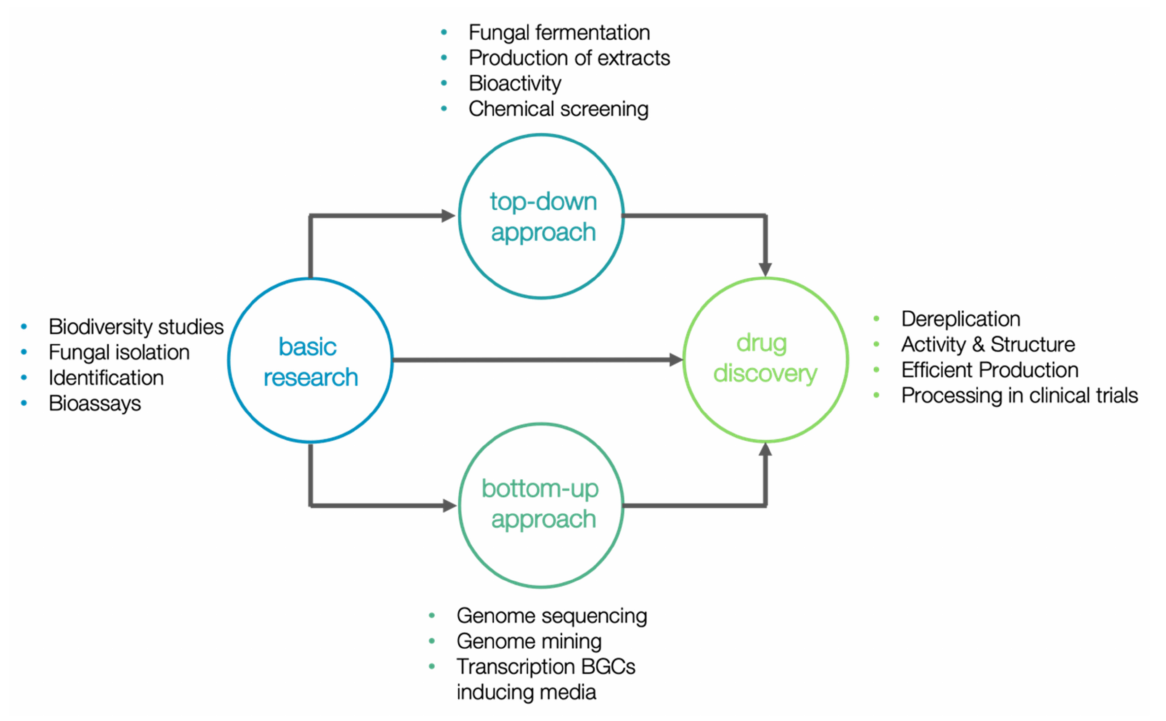
Figure 6. General representation of the pipeline for drug discovery in marine